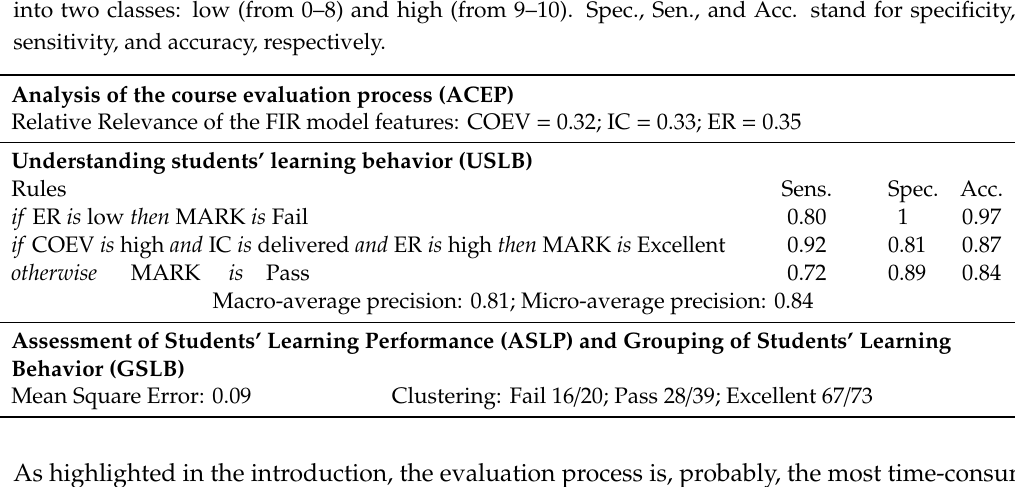
Table 5. ACEP, USLB, ASLP, and GSLB toolbox results for the model 4 of the didactic planning course. The MARK variable was discretized into three classes: fail (from 0–6), pass (from 6.9–8.9), and excellent (from 9–10). COEV was discretized into three classes: low (from 0–5), medium (from 5.1–7.9) and high (from 8–10). IC was discretize into two classes: delivered and not delivered. ER was also discretized into two classes: low (from 0–8) and high (from 9–10). Spec., Sen., and Acc. stand for specificity, sensitivity, and accuracy,